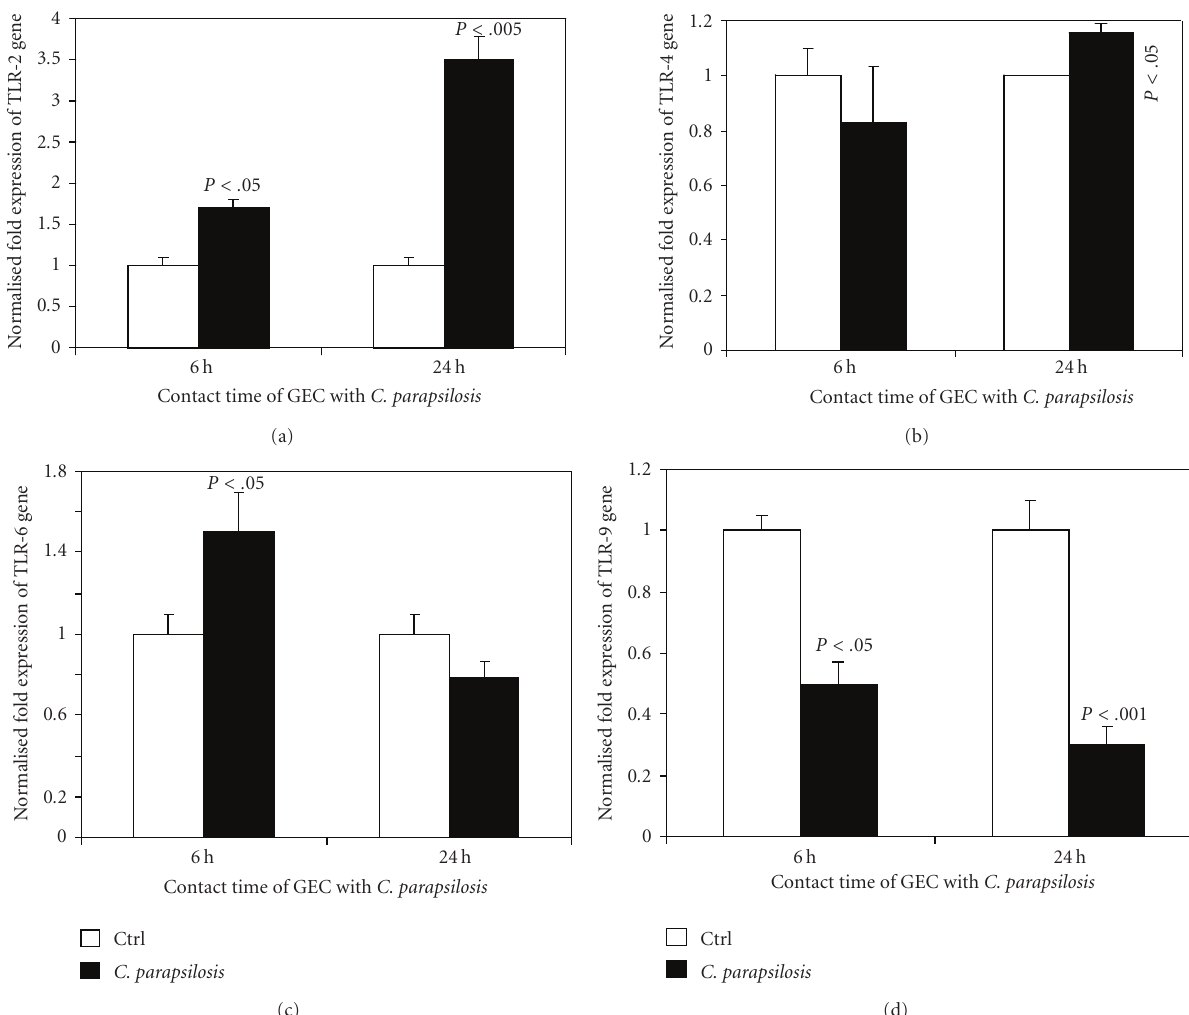
Figure 5: Quantification of mRNA expression levels of TLR-2, -4, -6, and -9 by gingival epithelial cells following infection with C. parapsilosis . Gingival epithelial cells were cultured with or without C. parapsilosis for 6 and 24 hours. Total RNA content was extracted from the cells following each culture period and was used for quantitative RT-PCR of the TLR-2, -4, -6, and -9 genes, as described in Section 2. Results are presented as a fold expression of the gene in the test sample compared to this gene expression in the control. Data are expressed as means ± SD from triplicate assays of three di ff erent experiments. (a) TLR-2 expression, (b) TLR-4 expression, (c) TLR-6 expression, and (d) TLR-9 expression. GEC: gingival epithelial